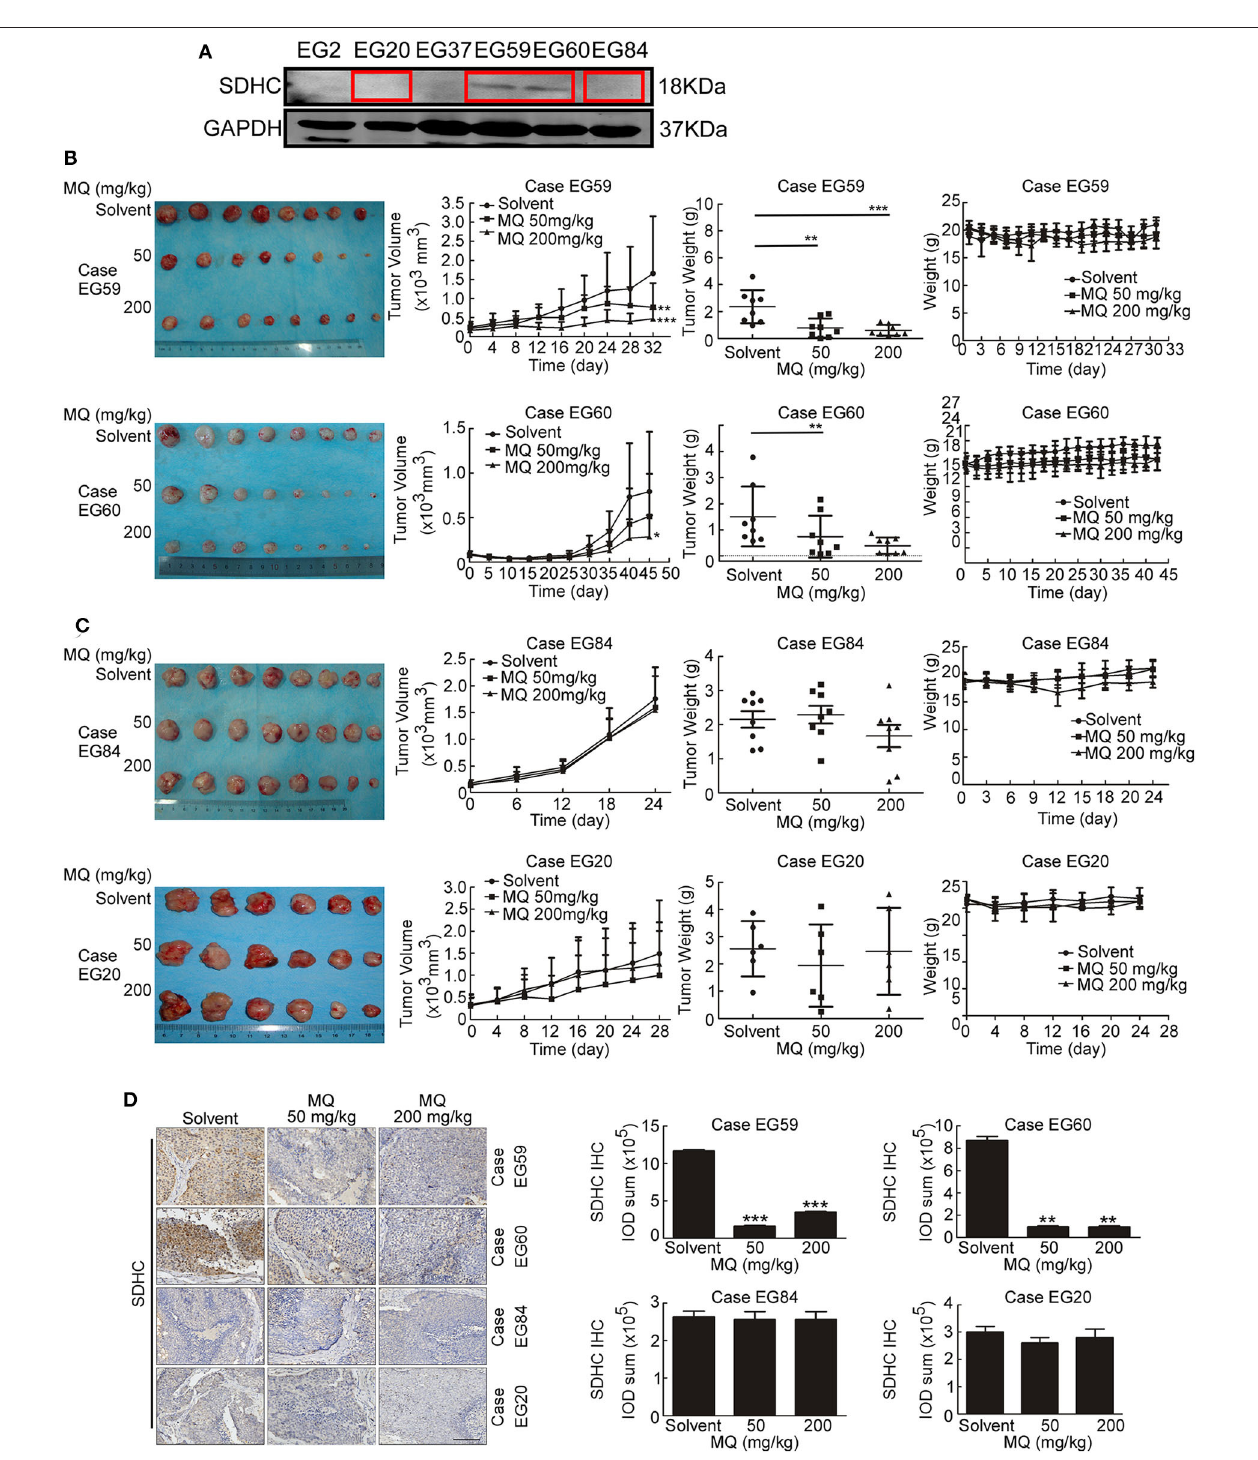
FIGURE 6 | Mefloquine inhibits tumor growth of ESCC PDX models. (A) SDHC protein level was detected in cases of ESCC tissues by Western blot; (B,C) Effect of MQ treatment on tumor growth. MQ significantly suppressed tumor growth of case EG59 and EG60, while not in case EG20 and EG84; (D) Immunohistochemistry analysis of SDHC with DAB staining in case EG59, EG60, EG20, and EG84 after MQ treatment. All data are shown as means ± S.D. The asterisks (*, **, ***) indicate a significant decrease ( p < 0.05, p < 0.01, p < 0.001, respectively).